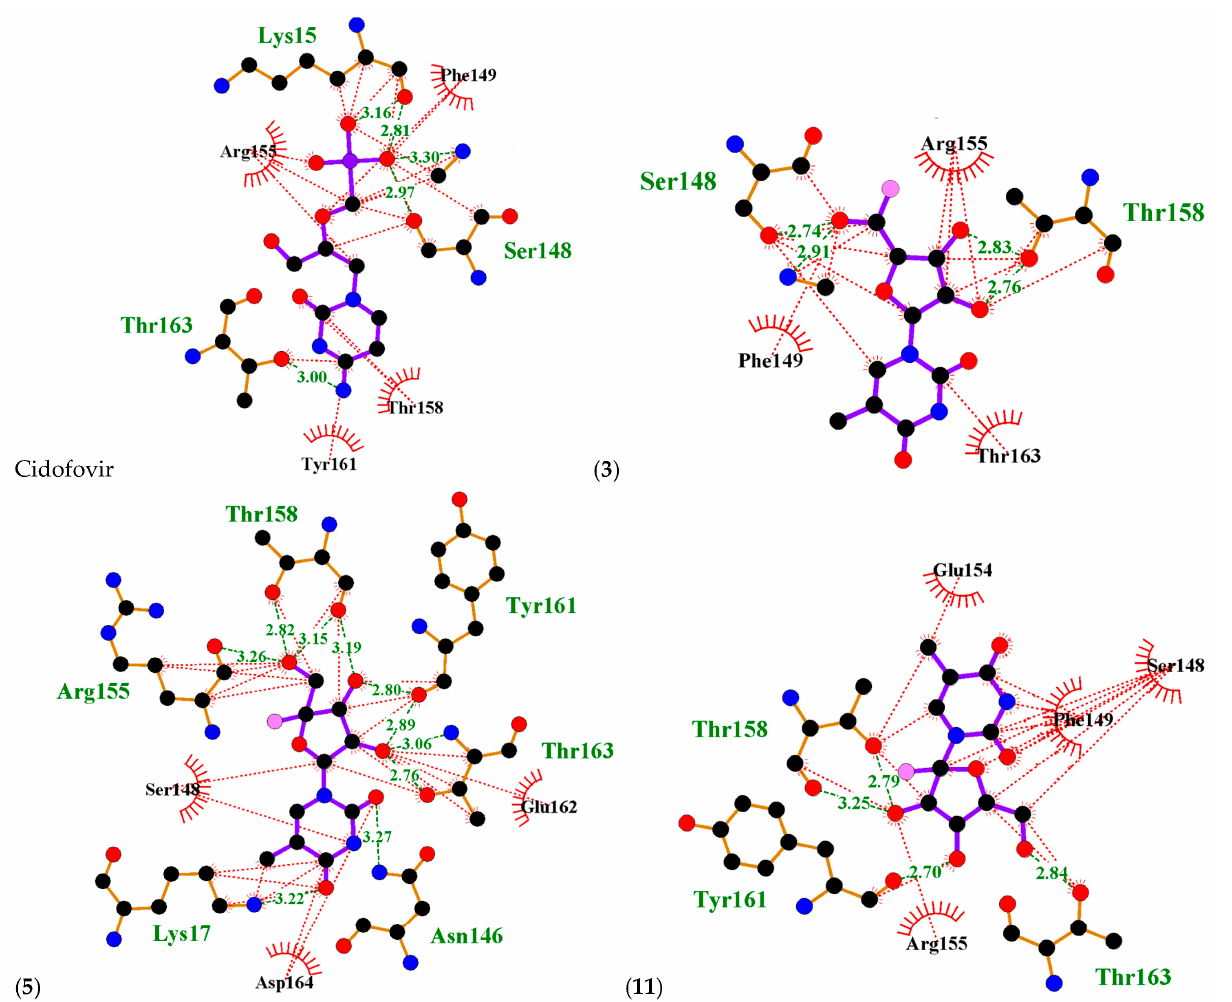
Figure 3. Ligplots showing the interacting residues of cidofovir and arabinofuranosyl-thymine-related structures ( 3 ), ( 5 ), and ( 11 ) with the cowpox CPXV203 protein. Purple lines, thymine structures ligand bonds; orange lines, non-ligand bonds; green dotted lines, hydrogen bonds labelled with distances in Å; red dotted lines, hydrophobic interactions; red circles, oxygen atoms; blue circles, nitrogen atoms; black circles, carbon atoms; pink circle, fluorine atoms; radial lines, non-ligand residues involved in hydrophobic contact(s).